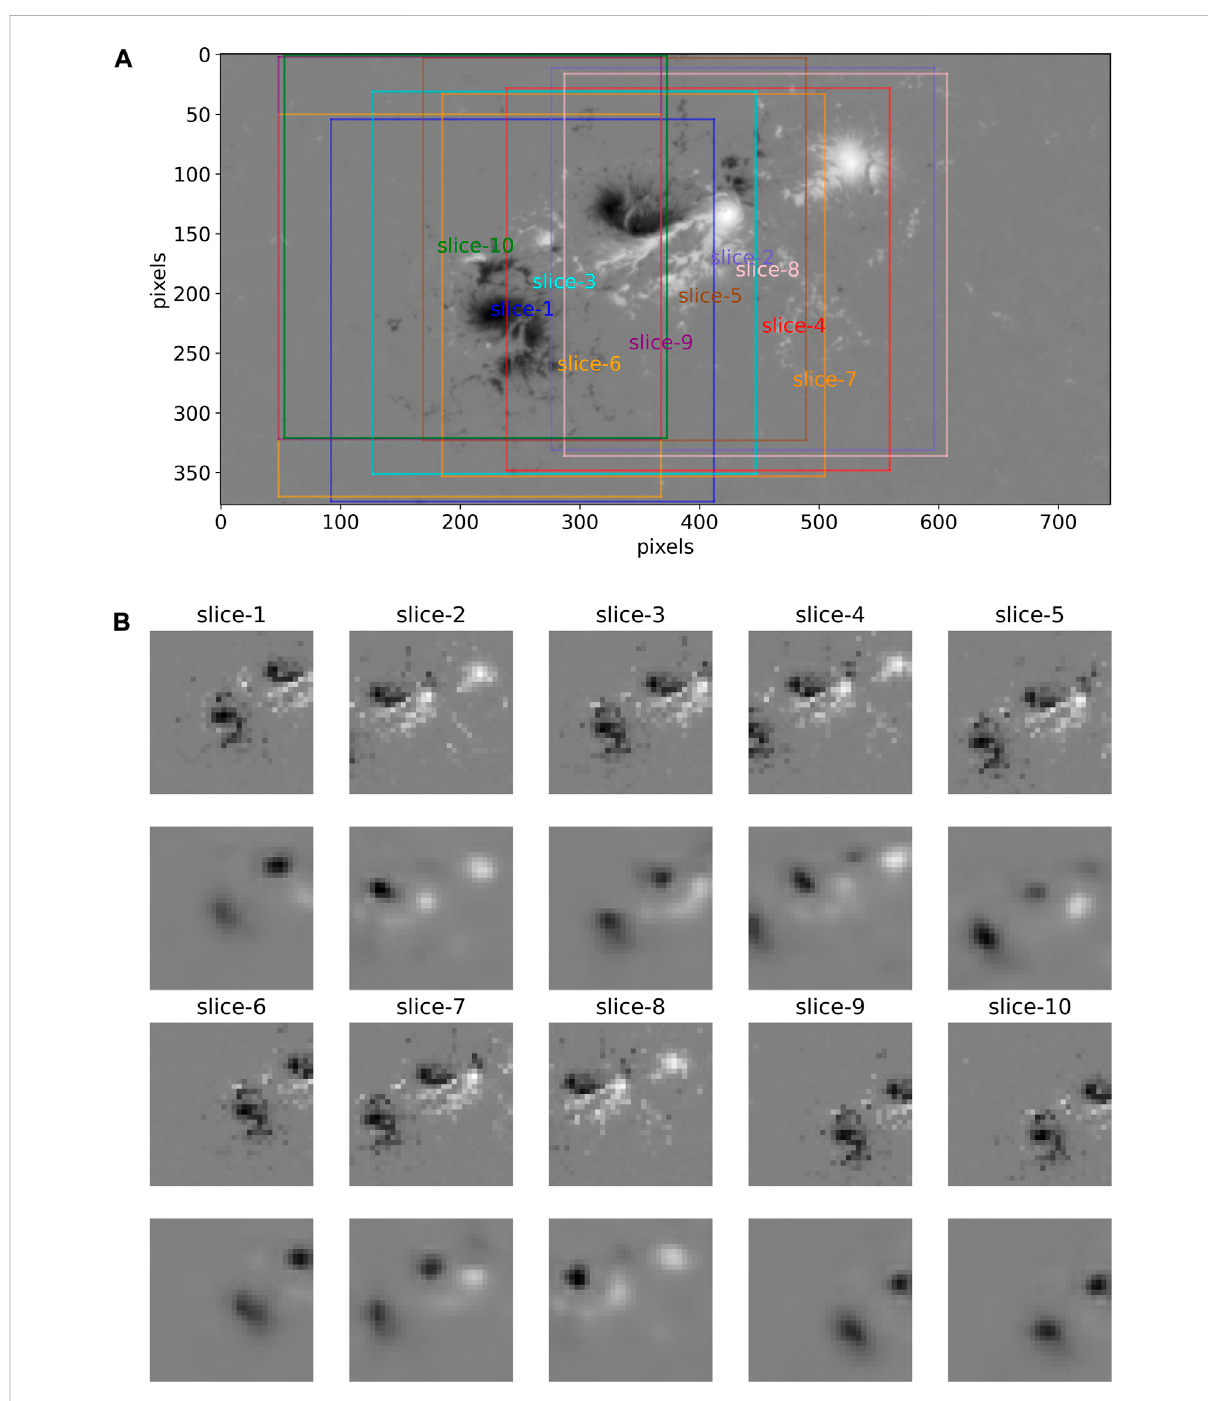
FIGURE 2 Illustration of the data preparation and the results by the auto-encoder network. (A) is the radial magnetic fi eld of AR11158 (corresponding to SHARP patch number 377) before the X2.2 fl are erupted at 01:56 UTC, on 15 Feb 2011. There are ten slices (with a size of 320 × 320 pixels) cut randomlyfromtheoriginalobservations. (B) arethetencompressedslicesinthe fi rstandthirdrows(withasizeof32×32pixels,accordingtotheten slices in Figure 2A) and the corresponding reconstructed slices in the second and fourth rows derived by the auto-encoder